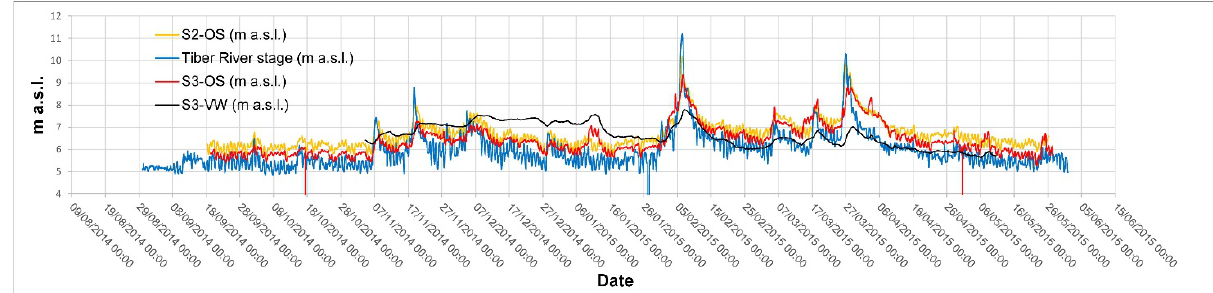
Figure 9. Recorded head level in the three piezometers and comparison with the Tiber River.